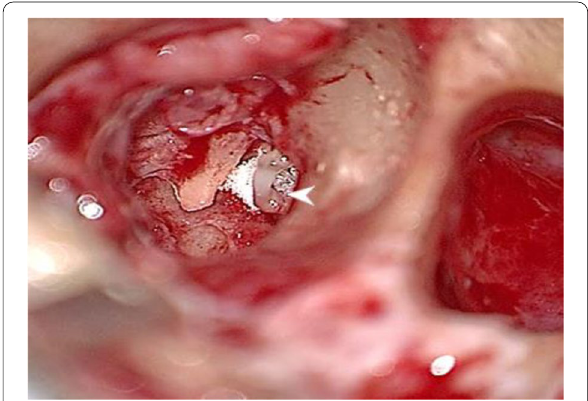
Fig. 2 Gelfoam placed below the incudo-stapedial joint to prevent spillage of the glass ionomer